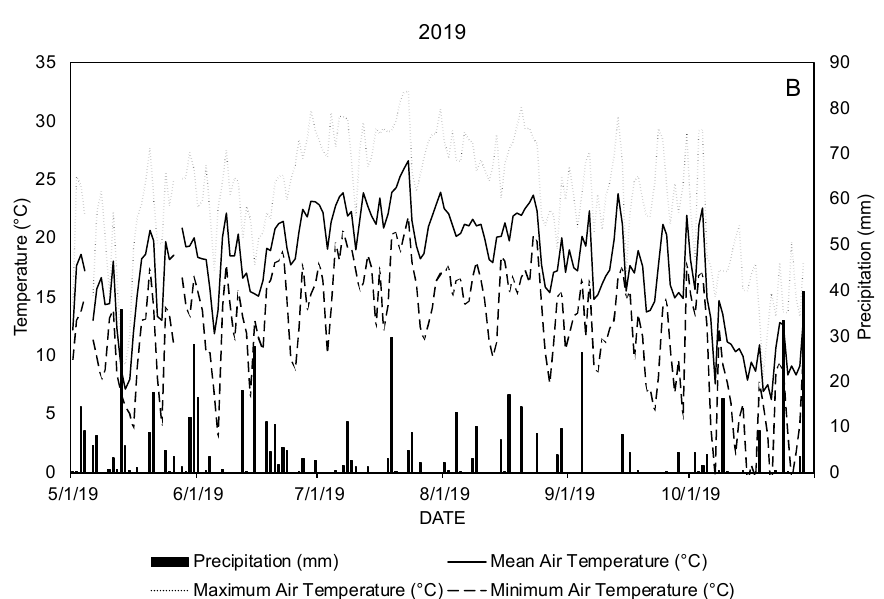
Figure 2. Daily precipitation (mm) and air temperature ( ◦ C) at Rock Springs, PA, field sites during the ( A ) 2018 and ( B ) 2019 growing seasons. Table 1. Number of days after planting (DAP) and growing degree days accumulated using two base temperatures from the date of planting of sweetpotatoes until the corresponding harvest